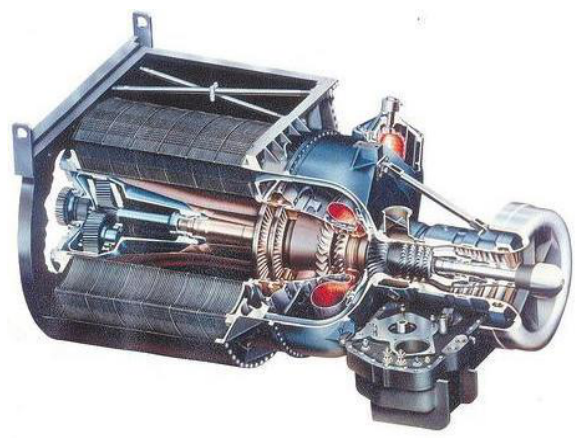
Fig. 14. The AGT-1500 engine (source: M1Abrams tank description,